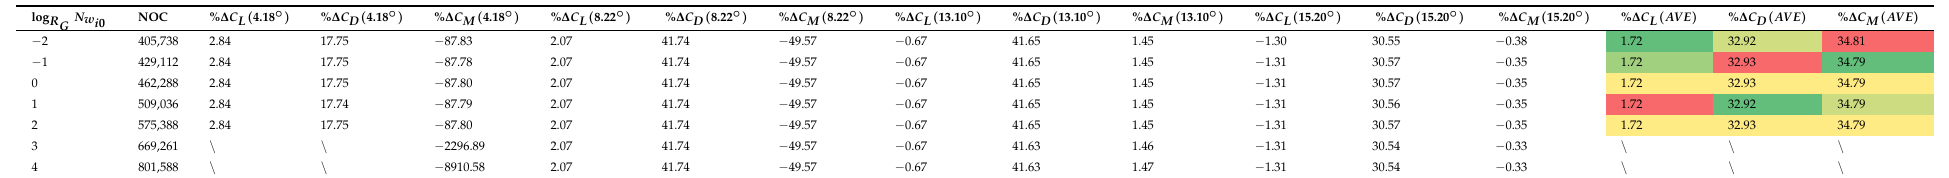
Table 20. Comparison of the results of H-mesh based on various wake nodes with that of experimental benchmark data adopted from [25] in relative differences with 300 nodes in wake directions for reference setting.